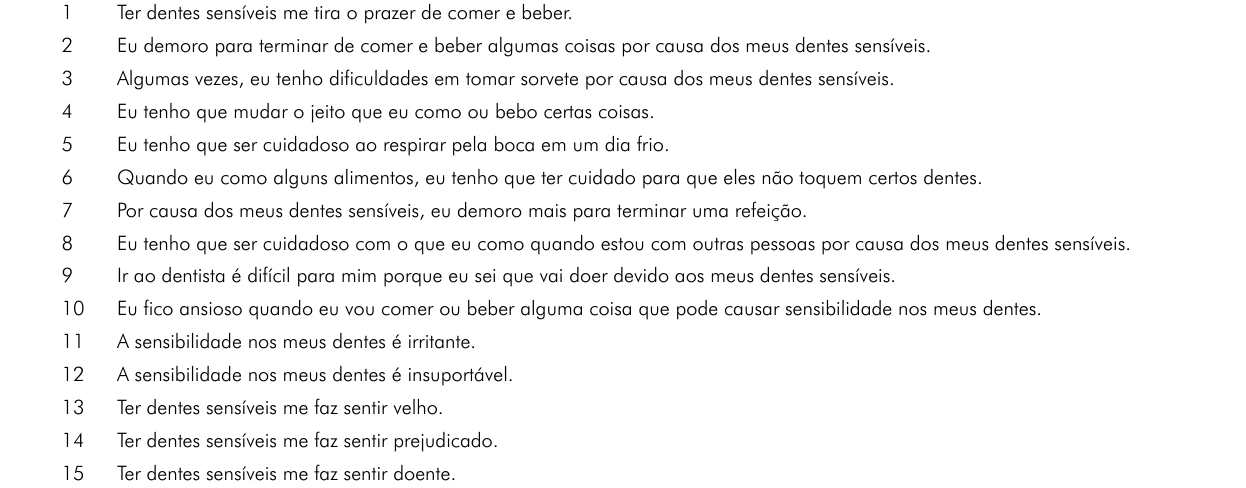
Figure. The Brazilian version of the 15-item dentin hypersensitivity experience questionnaire (DHEQ-15).